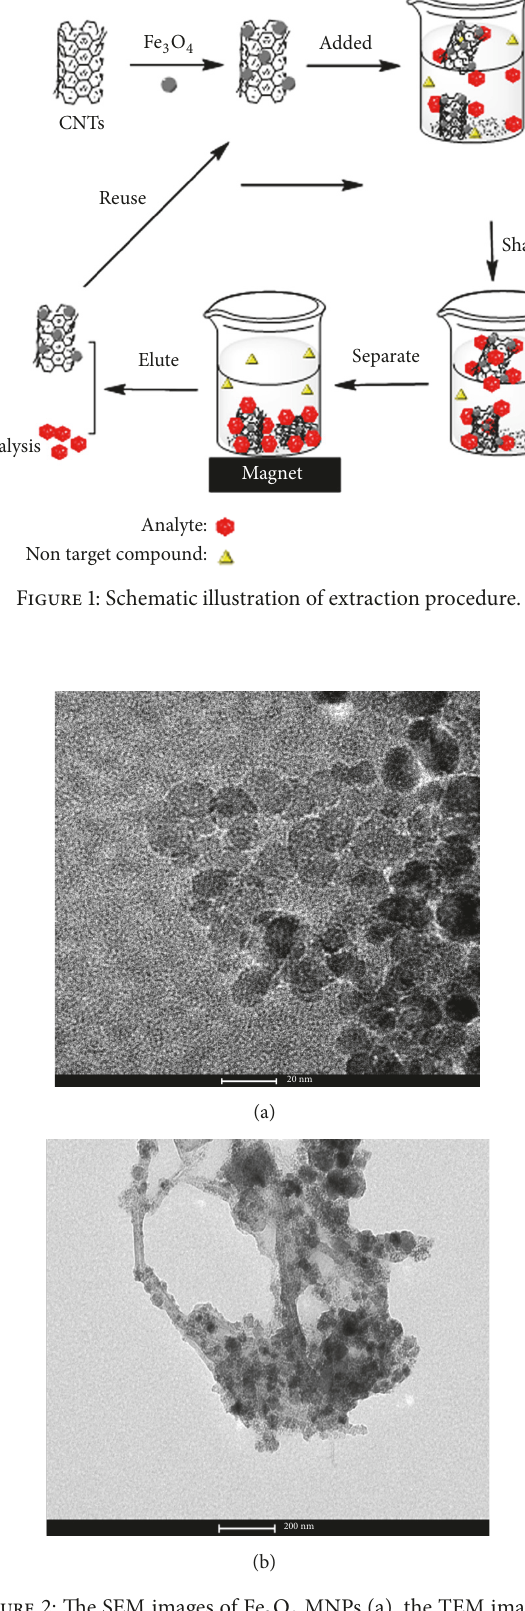
Figure 2: The SEM images of Fe 3 O 4 MNPs (a), the TEM image of Fe 3 O 4 @CNTs MNPs-diatomite composite (b).